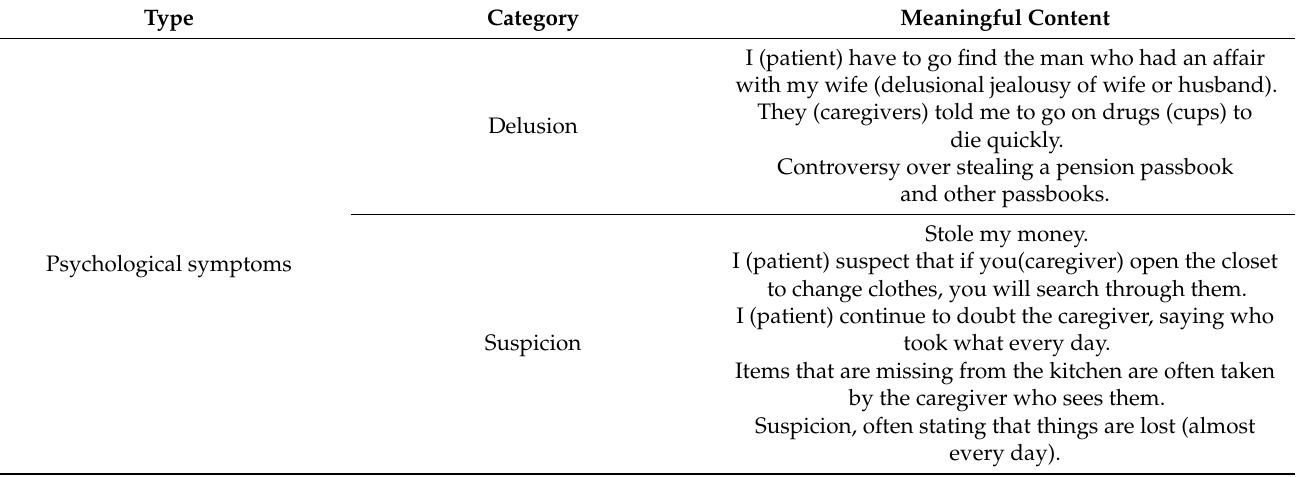
Table 2. Content analysis of the most difficult aspects of caring for dementia patients as a current caregiver.